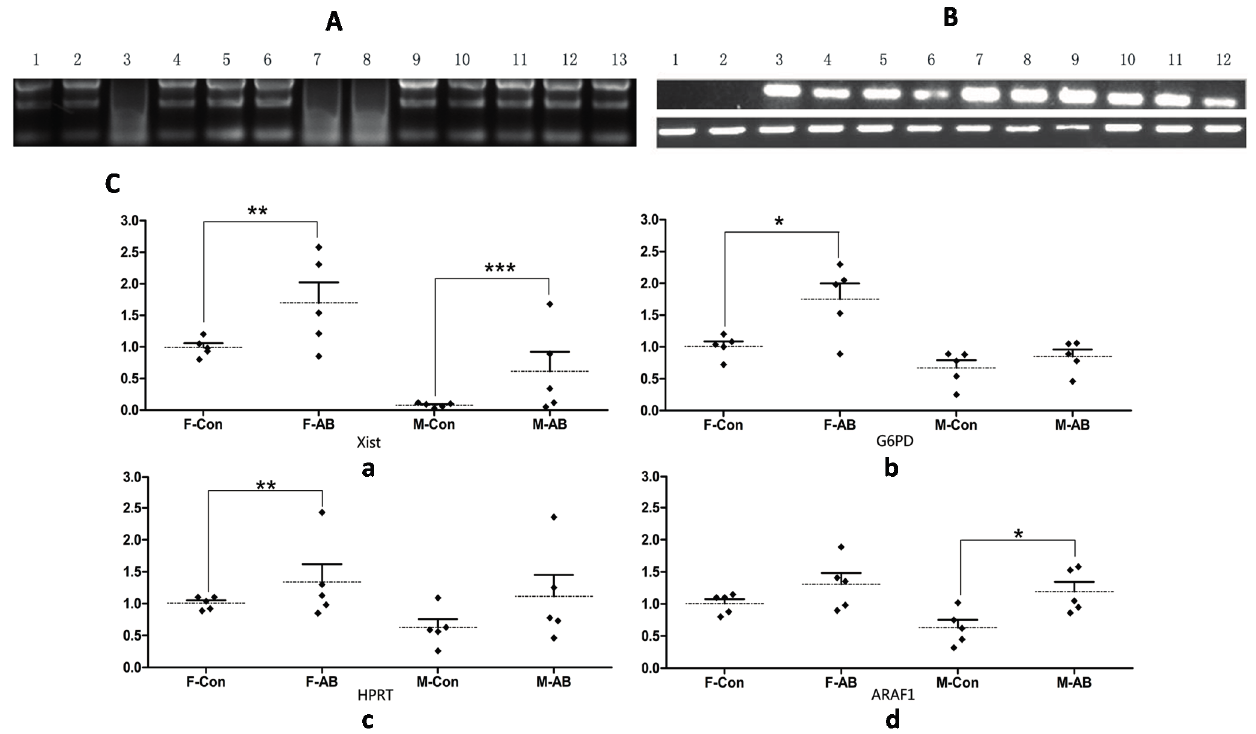
Figure 2. Transcription patterns of X-linked genes. ( A ) The electrophoresis pattern of total RNA extracted from the samples . Lanes 1–3, 4–6, 7–8, 9–10, 11–12 and lane13 represented group 1, 2, 3, 4, 5 and 6 respectively. Three bands represented the high quality of RNA, the smear band showed the degraded RNA; ( B ) Xist gene amplification by RT-PCR (upper ladder). GAPDH was included as an internal control (lower ladder). Lanes 1: male fetus derived from normal fertilization; Lanes 2–6: male aborted fetuses; Lanes 7: female fetuses derived from normal fertilization; Lanes 8–12: female aborted fetuses and ( C ) Gene expression levels of ( a ) X inactivation-specific transcript (Xist); ( b ) glucose-6-phosphate dehydrogenase (G6PD); ( c ) hypoxanthine guanine phosphoribosyltransferase (HPRT1) and ( d ) V-raf murine sarcoma 3611 viral oncogene homolog 1 (ARAF1) were determined by q-PCR. * denotes p < 0.05; ** denotes p < 0.01; *** denotes p < 0.001. Dotted line: the average level of gene expression. Solid line: standard